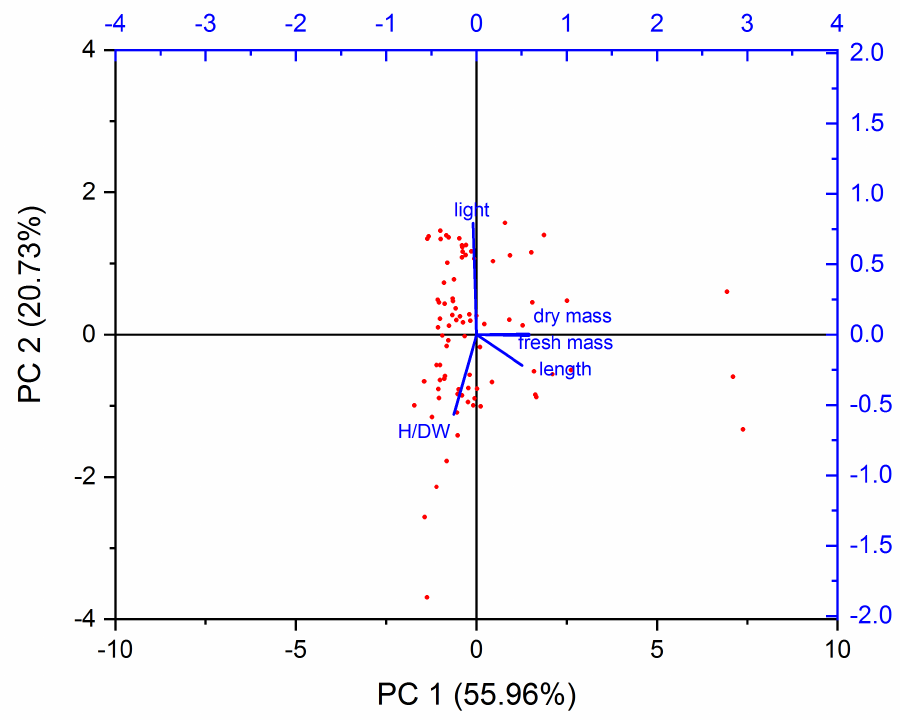
Figure 5. Principal components analysis (PCA) of microgreens from biometrical analyses. Two- dimensional (2D) scores plot of species of microgreens from different spectral compositions of light (red points) presented relationships between species and the measured biometric